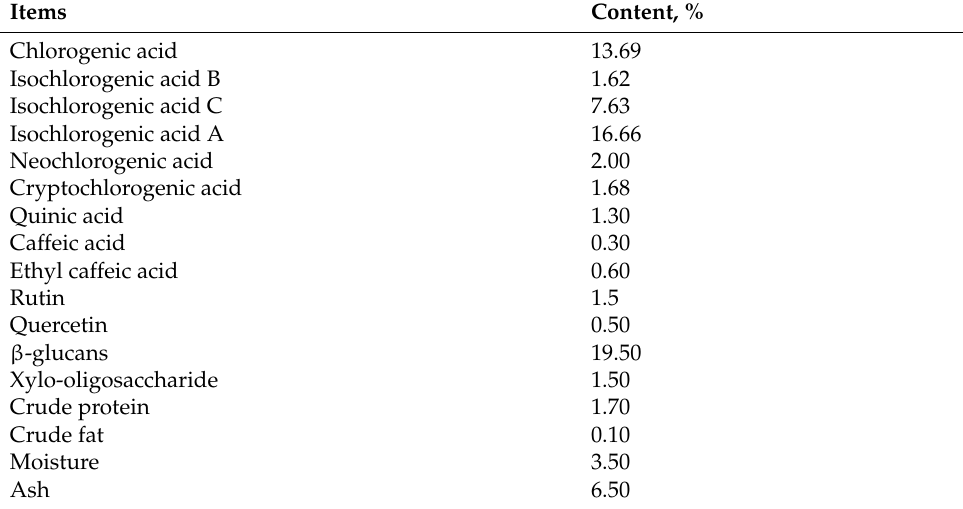
Table 2. Identified components and their contents in stevia residue extract [11] (a)